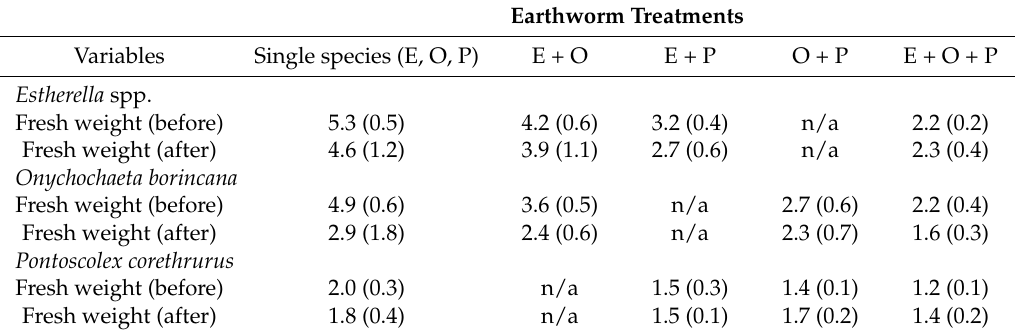
Table 1. Average fresh biomass of Estherella spp. (E), Onychochaeta borincana (O), and Pontoscolex